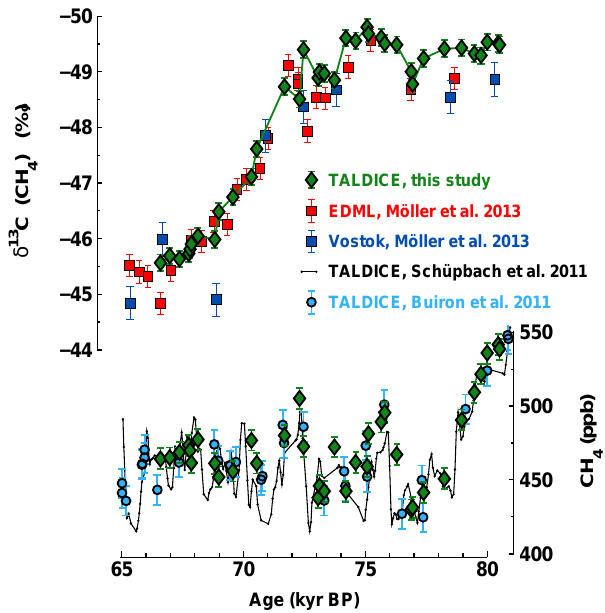
Figure 9. Comparison of our δ 13 C–CH 4 and [CH 4 ] measurements with published results for an interval showing strong variations in both parameters. All data are plotted on a common age scale (Veres et al.,